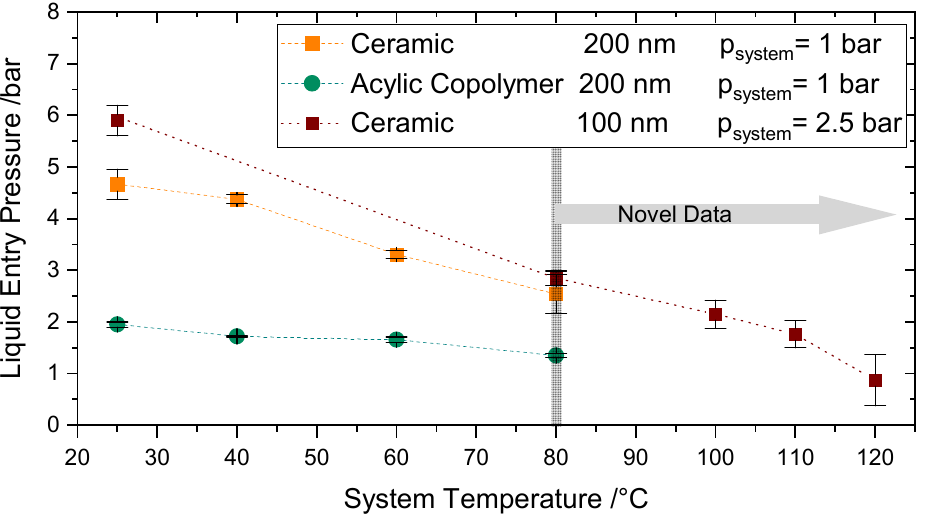
Figure 11. Influence of system temperatures up to 120 ◦ C on Liquid Entry Pressure for Ceramic Membrane 100 (Red) at a system pressure of 2.5 bar compared to the Liquid Entry Pressure for a Versapor Membrane 200 (Green) and Ceramic Membrane 200 (Orange) up to 80 °C.